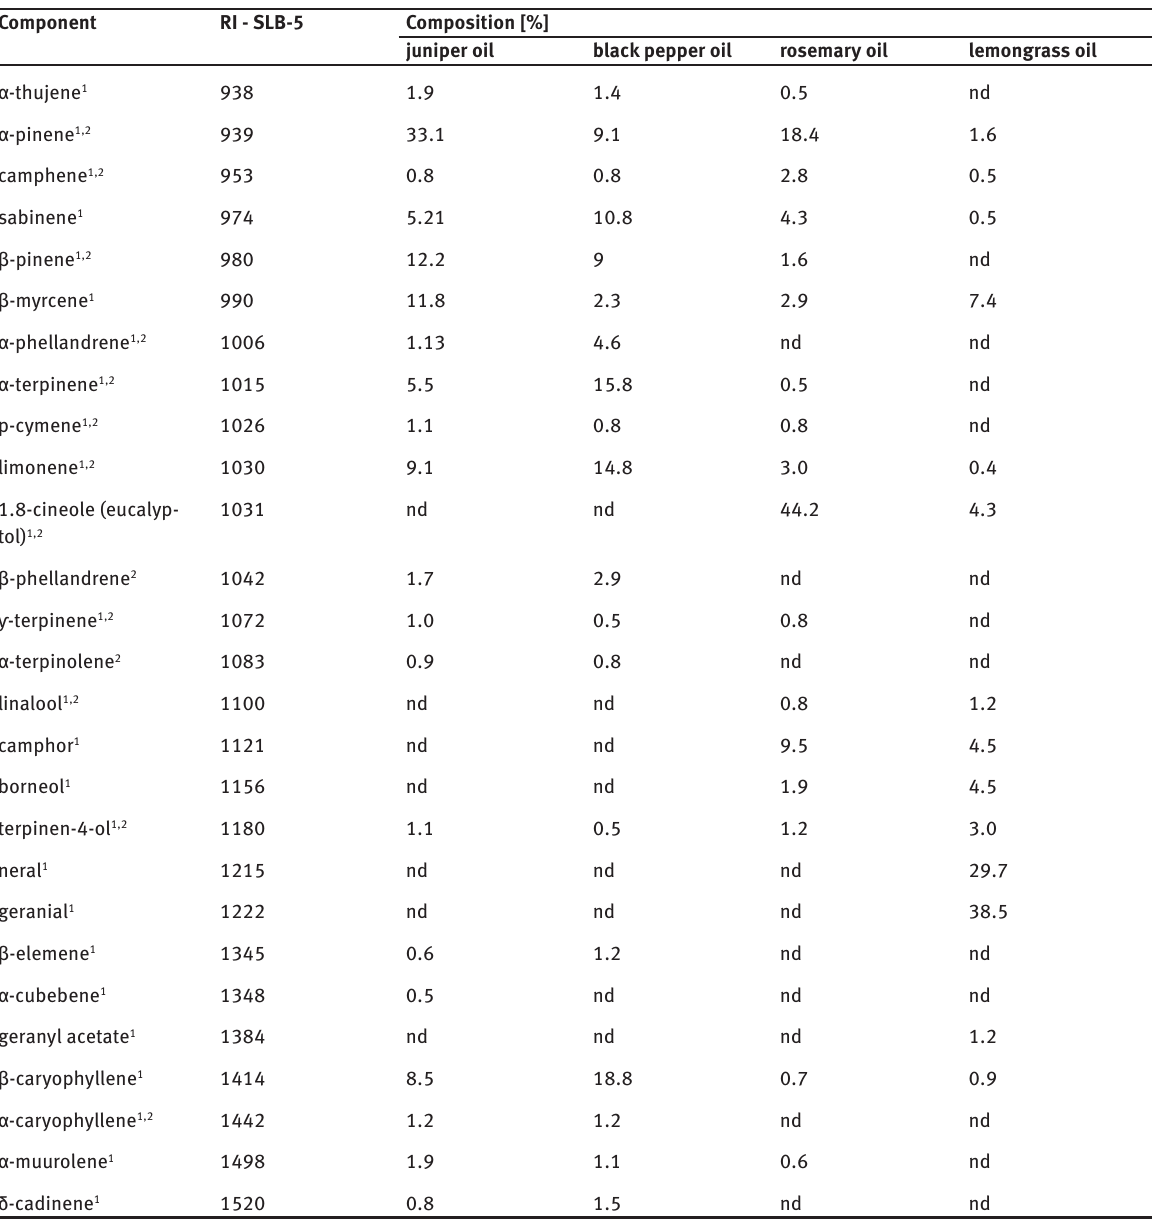
Table 2: Composition of EOs [%]. Component RI -